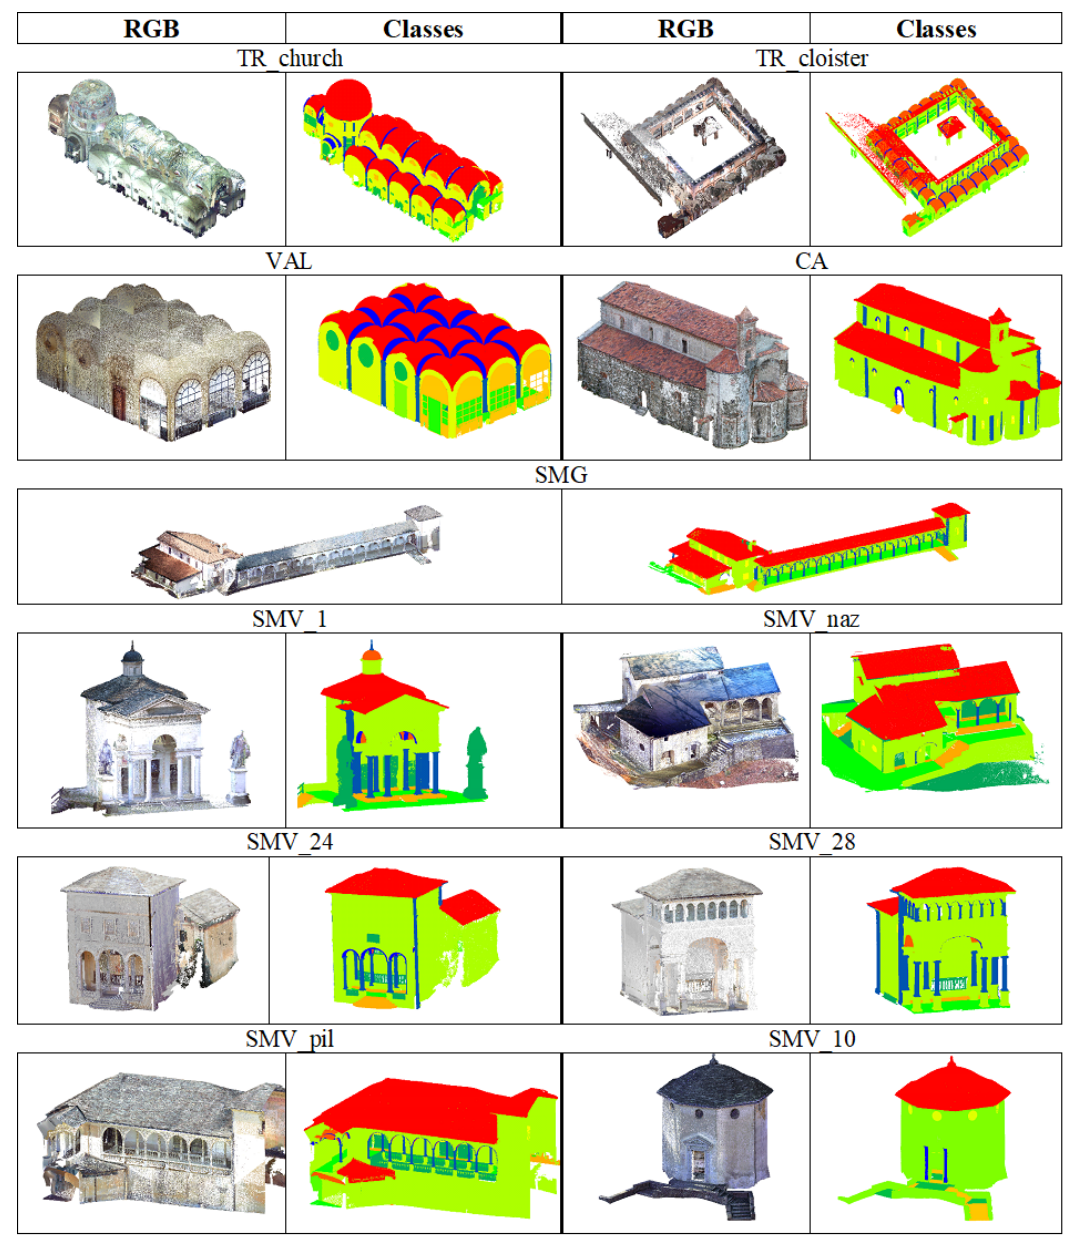
Figure 2. ArCH dataset. On the left column the RGB point clouds and on the right the annotated scenes. 10 classes have been identified: Arc, Column, Door, Floor, Roof, Stairs, Vault, Wall, Window and Decoration. The Decoration class includes all the points unassigned to the previous classes, as benches, balaustrades, paintings, altars and so